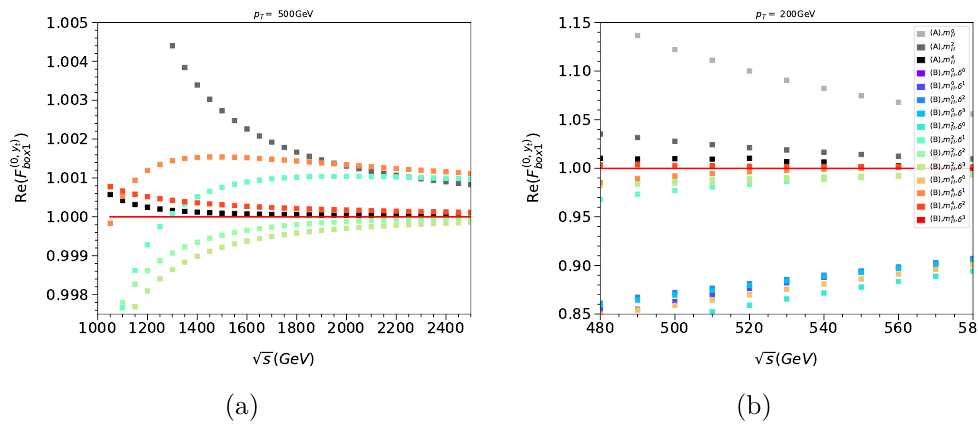
Figure 8 . Real part of F box1 for different values of p T and various expansion terms in m H and δ .